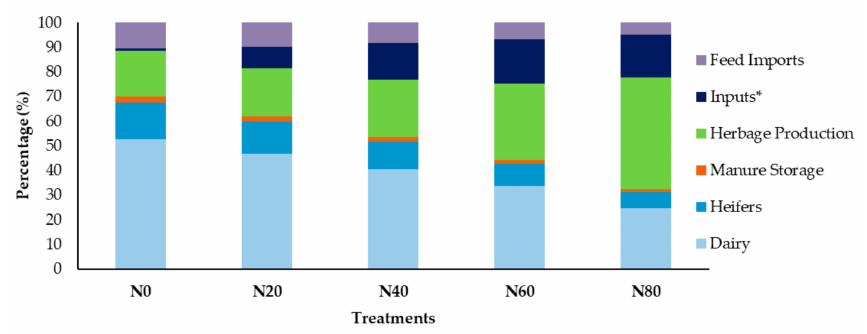
Figure 1. The relative contributions of the different system units to the product CF (%) among the different treatments (N0, N20, N40, N60 and N80). * Inputs (e.g., mineral fertilizer, lime, pesticides and seeds).